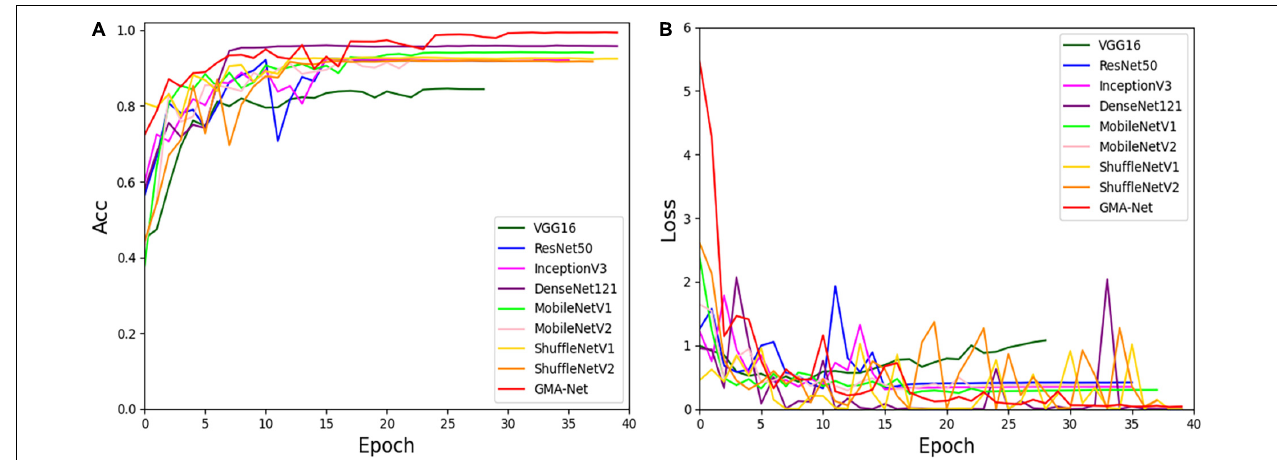
FIGURE 5 | Accuracy curve and loss curve of rubber leaf disease validation set. (A) Accuracy curve. (B) Loss curve.